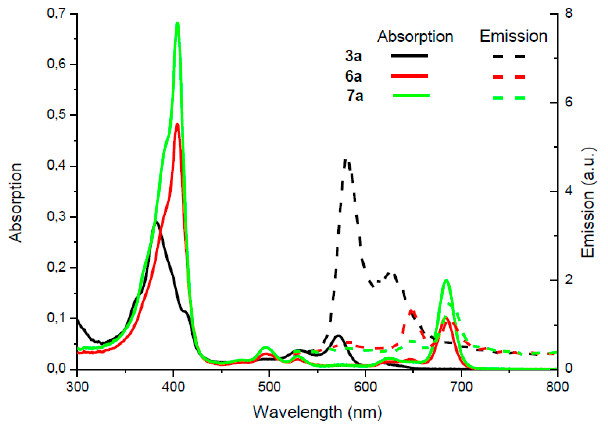
Figure 2. Absorption spectra of compounds 3a , 6a , and 7a in chloroform (c = ~2 × 10 − 6 mol.L − 1 ).